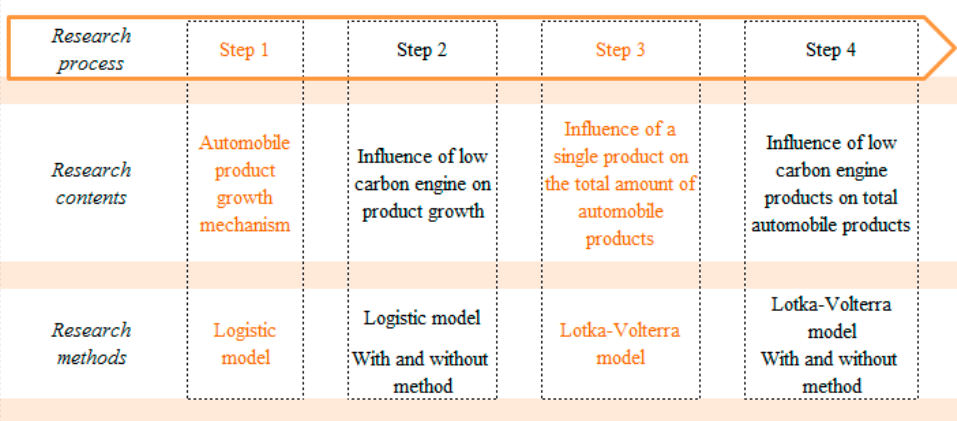
Figure 1. Research structure and